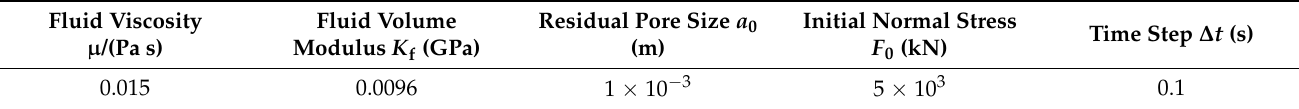
Table 3. Computational parameters of fluid.